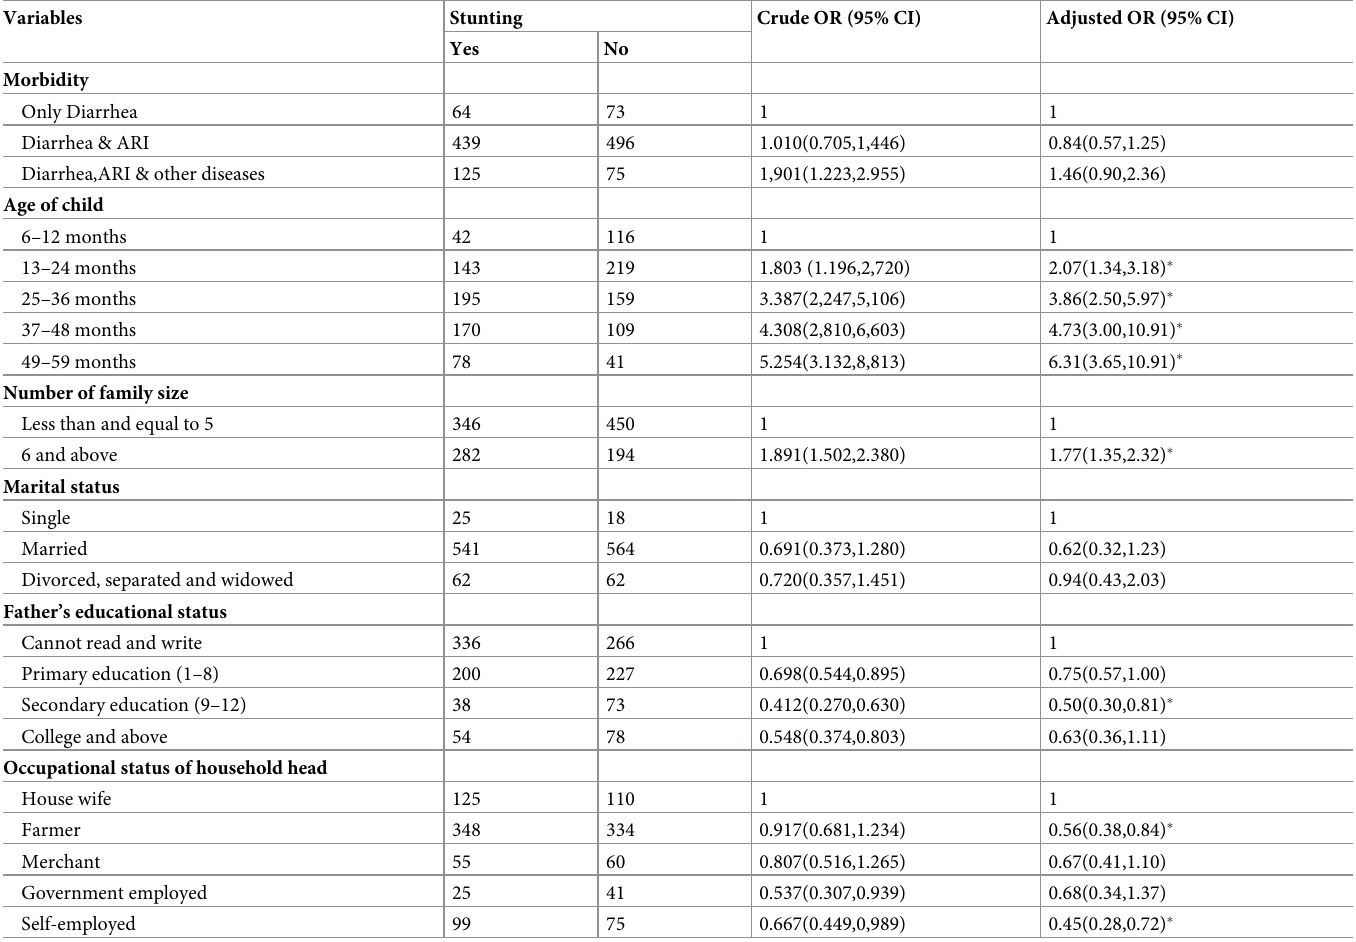
Table 4. Binary logistic regression analysis output for factors associated with stunting among children age 6-59months, in Libo-kemekem district, northwest